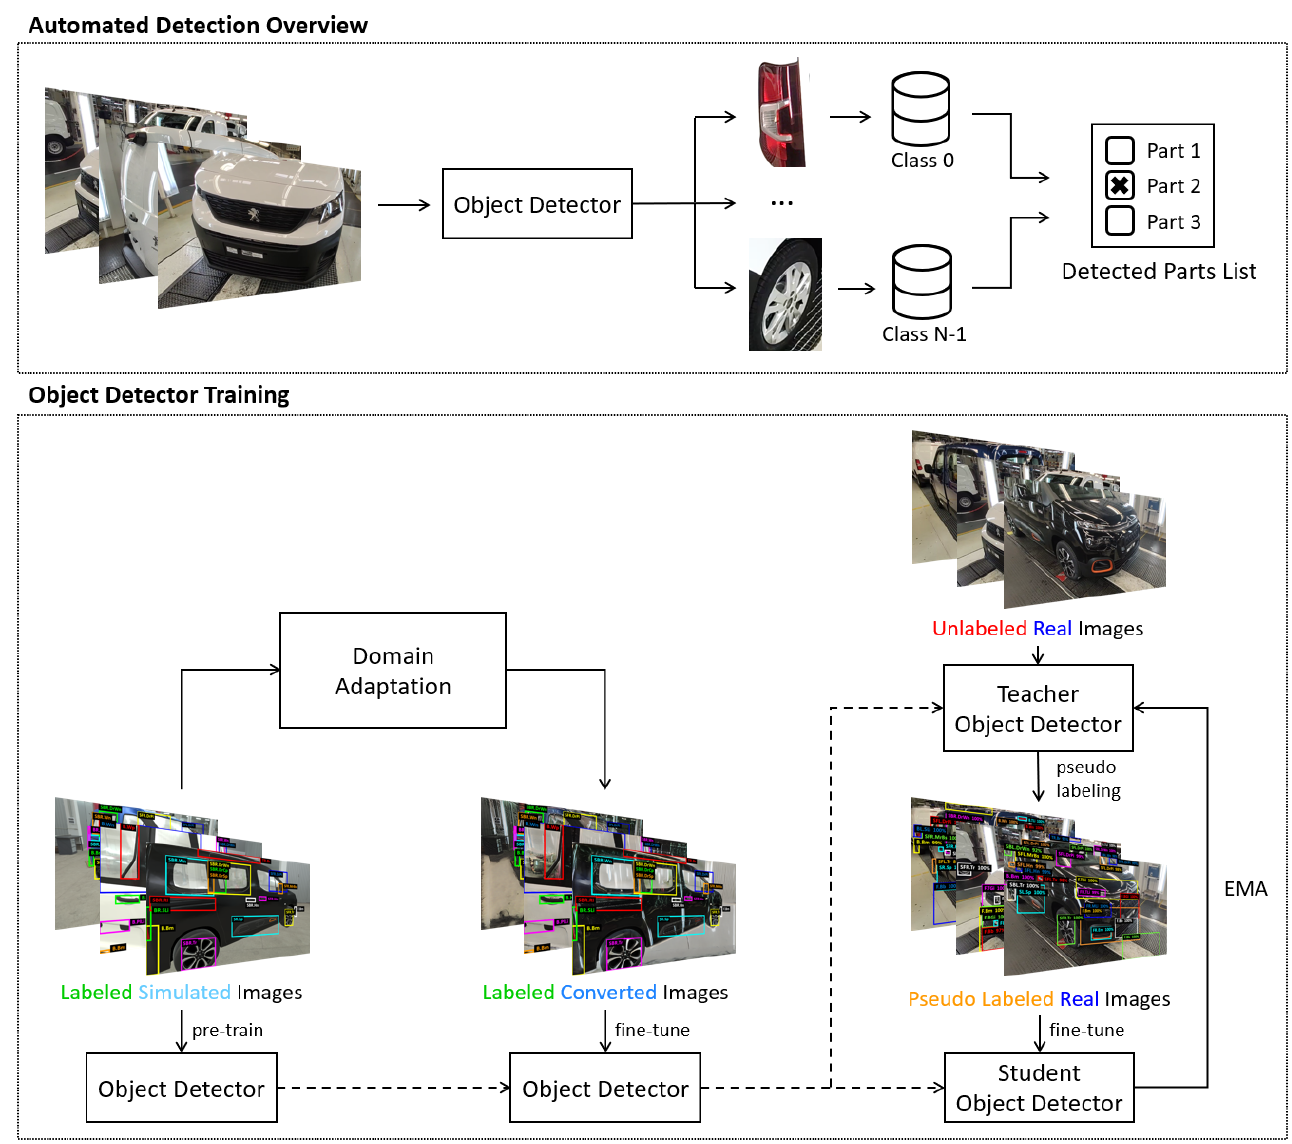
Figure 3. Overall architecture of the hierarchical automated detection module ( top ) and its iterative training process ( bottom ). First, an object detection neural network identifies vehicle parts (e.g., left rear view mirror) and each object is forwarded to the corresponding retrieval sub-module, responsible for outputting the final code for each part (e.g., left rear view mirror of a commercial Peugeot). The training process can be viewed as a semi-supervised object detection pipeline with 3 main stages: pretraining on labeled simulated images which are later converted into more realistic versions, which, in turn, are used to fine-tune the detector. Training is completed by combining both labeled converted images with pseudo labeled real images, in a teacher-student framework with Exponential Moving Average (EMA) updates of the teacher. The dashed arrows represent the weight transfer between the models obtained at each